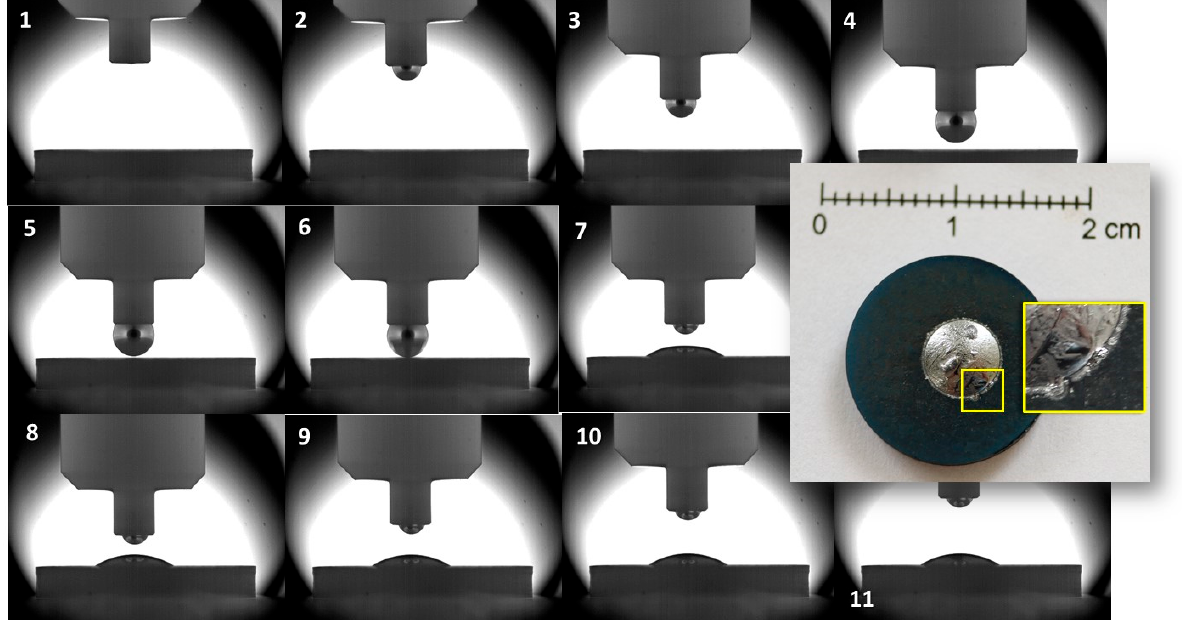
Figure 6. Post-mortem pictures of the Si-24at%Ti/GC sample and the time sequence of images recorded during the wetting test performed by the dispensed drop method at T =1450 °C under an Ar atmosphere.